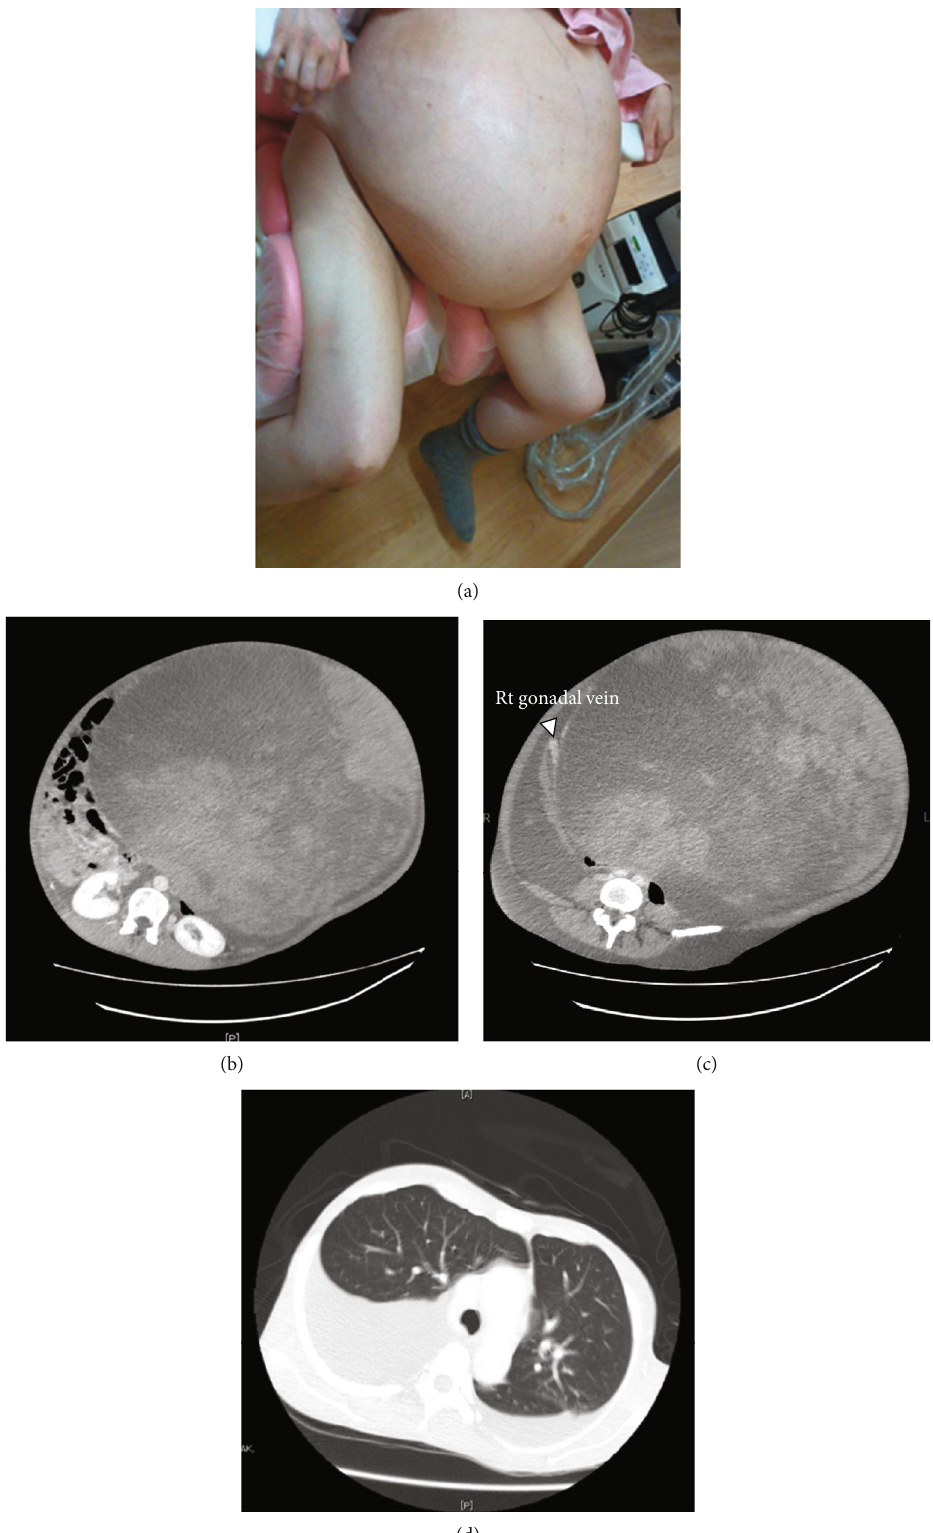
Figure 1: Physical and imaging test fi ndings before operation. (a) Her abdomen was markedly distended, making it di ffi cult for her stand by herself. (b, c, d) Findings of enhanced-computed tomography. (b) Majority of the mass was homogenous with a density of subcutaneous fat and no obvious hypervascular lesions. (c) The right gonadal artery and vein fl ow into the tumor. (d) The pleural e ff usion was detected in right thoracic